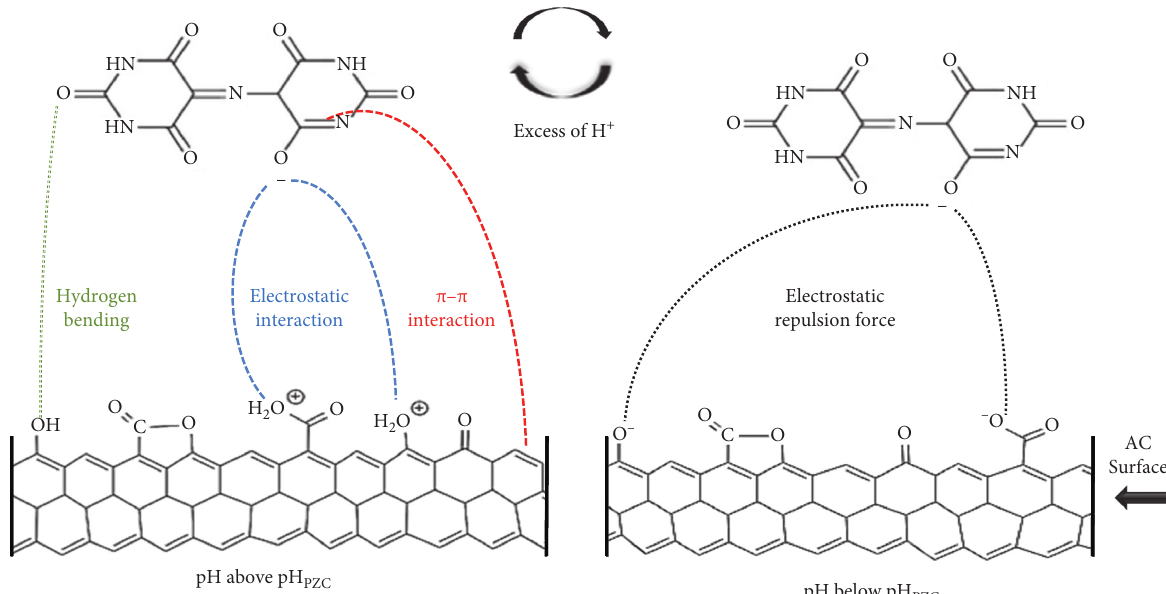
Figure 9: Proposed mechanism of adsorption/desorption of Murexide on activated